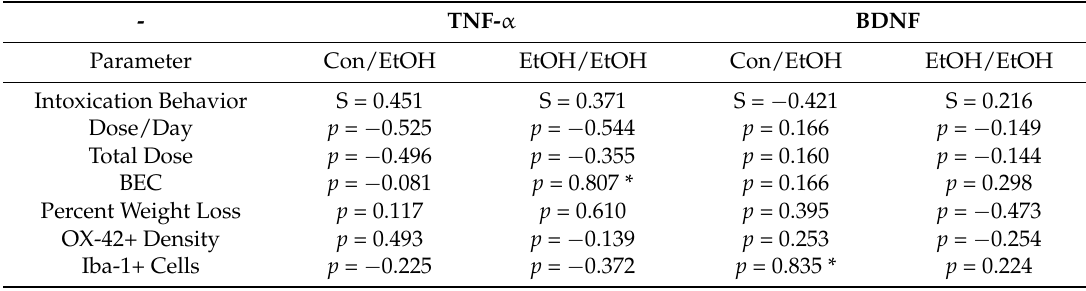
Figure 7. Correlations of Cytokines: ( A ) A positive correlation between blood ethanol concentration (BEC) and tumor necrosis factor- α (TNF- α ) concentration. Animals with BECs over 400 mg/dL appear to have an increase in TNF- α . ( B ) A positive correlation between hippocampal estimates of microglia number and brain derived neurotrophic factor (BDNF) concentrations in the Con/EtOH group. A decline in the number of microglia cells correlated with decreases in BDNF concentrations. Table 5. Select Hippocampal Cytokine and Growth Factor